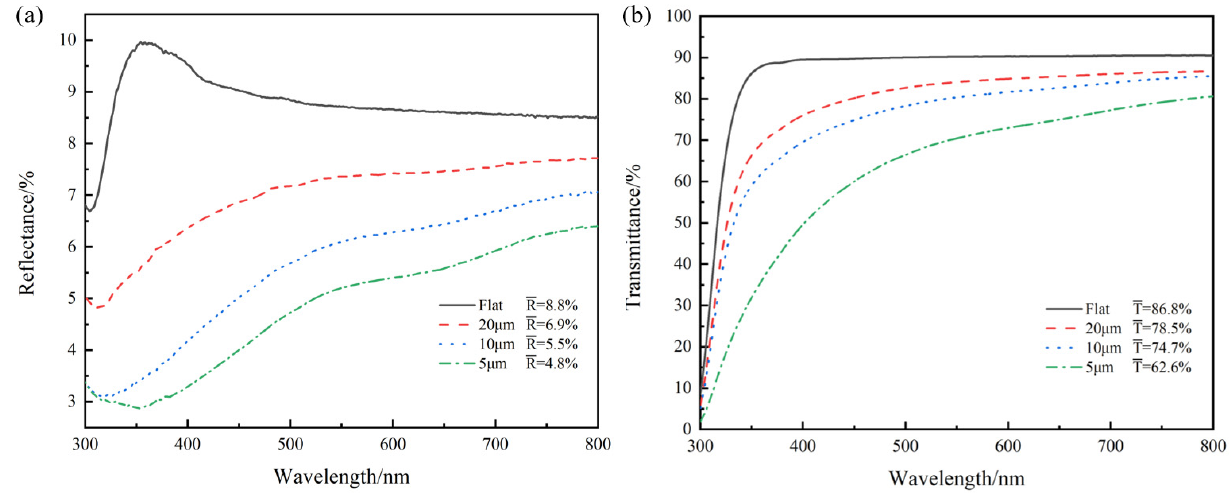
Figure 8. Reflectance and transmittance of unprocessed samples and laser-textured samples at different scanning distances. ( a ) the reflectance spectrum, and ( b ) the transmittance spectrum.